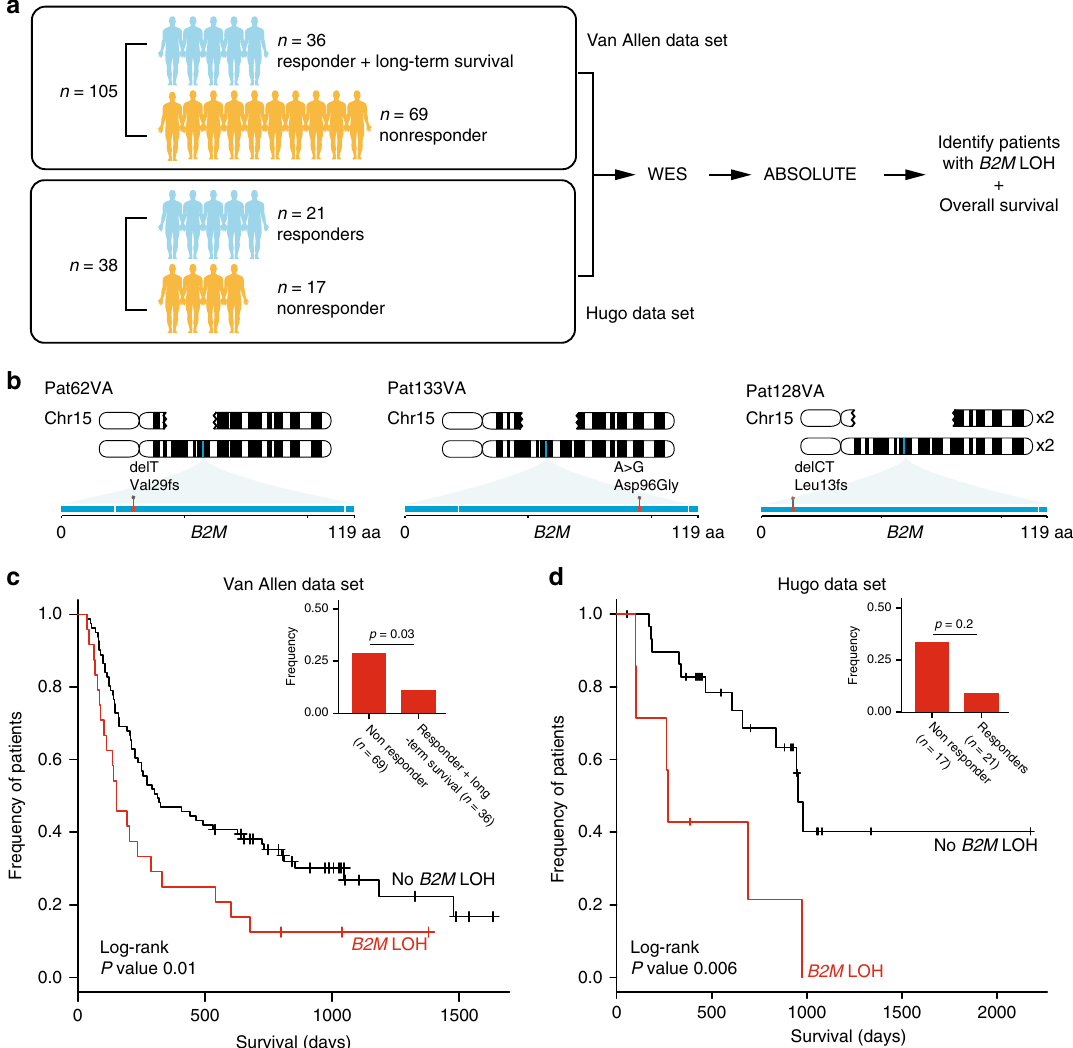
Fig. 4 Clinical relevance of B2M aberrations in two independent cohorts. a Analysis work fl ow for both Van Allen (105 patients pre-anti-CTLA4 treatment) and Hugo (38 patients pre-anti-PD1 treatment) data sets. For both data sets, we analyzed whole exome sequences of paired tumor and normal biopsies using the same pipeline used to analyze our cohort. b Illustration of three non-responders in the Van Allen data set with nucleotide mutations in B2M accompanied by loss of the wild-type allele. Gaps in the top chromosome depict the deleted region in each patient. Exons in B2M are shown as a horizontal blue rectangle, with mutations found in each patient highlighted in red. c Kaplan – Meier survival curves for patients in the Van Allen data set with (red) and without (black) B2M LOH. Log-rank p value is shown ( p < 0.01). Inset shows the frequency of patients with B2M LOH in non-responders vs. responders and long-term survivors. One-sided Fisher ’ s exact p value is shown ( p < 0.03). d Identical analysis performed for the Hugo data set as in